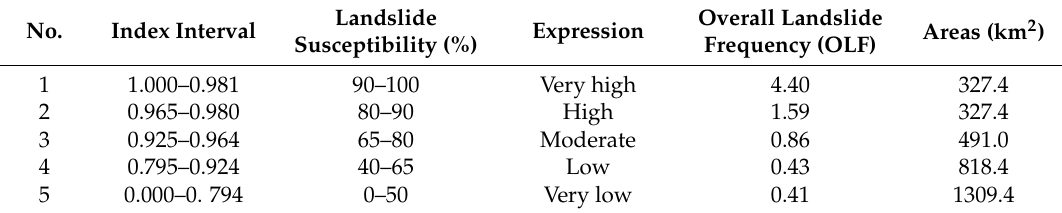
Table 3. Characteristics of the landslide susceptibility classes derived from the BE-LMTree model the study area.